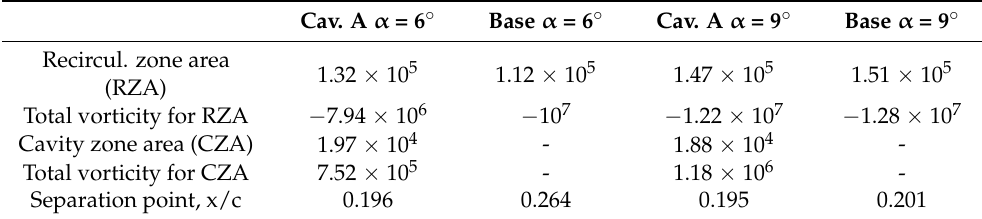
Table 5. Recirculation zone